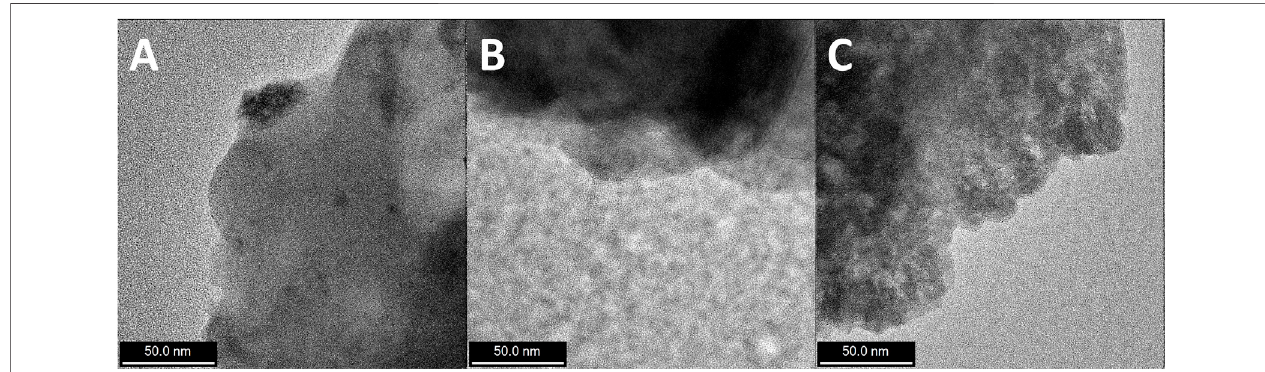
TABLE 1 | UV-Vis responses of HTB and HTB-co-P3HT in various solvents. Compound